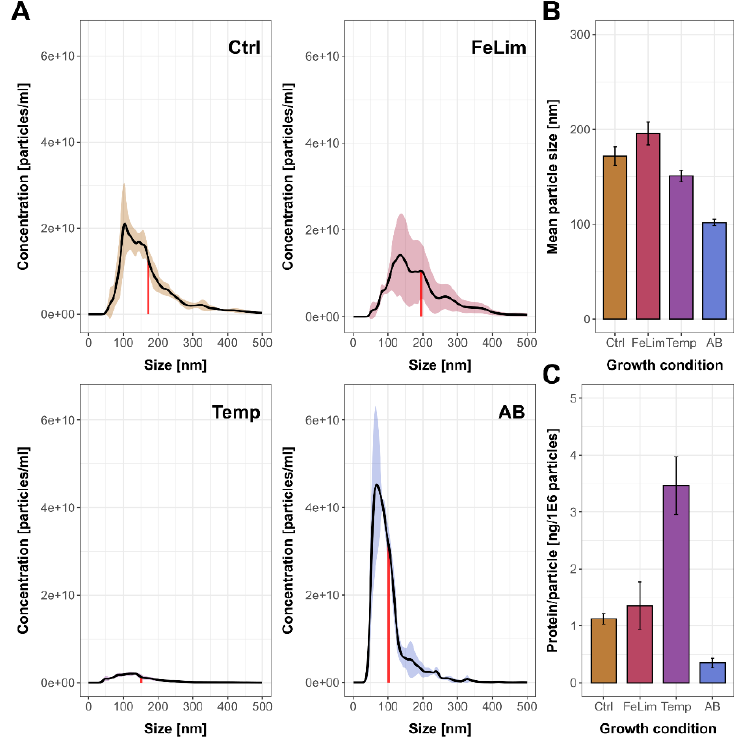
Figure 5. Nanoparticle-tracking analysis of Aeromonas salmonicida OMVs. ( A ) Size distribution and concentration determination of the outer membrane vesicle fraction by nanoparticle-tracking analysis (Ctrl — control; FeLim — iron limitation; Temp — elevated temperature; AB — antibiotic stress). The colored areas indicate the 75% confidence intervals of the data between replicates, and the red line indicates the mean particle size of the respective condition. ( B ) Mean particle sizes within the outer membrane vesicle fraction of the applied conditions. ( C ) Protein-to-particle ratio within the outer membrane vesicle fraction of the applied conditions. OMV protein concentration determinations were obtained by BCA assay before S-Trap protein digest for mass spectrometry analysis. Error bars indicate standard deviations between replicates.